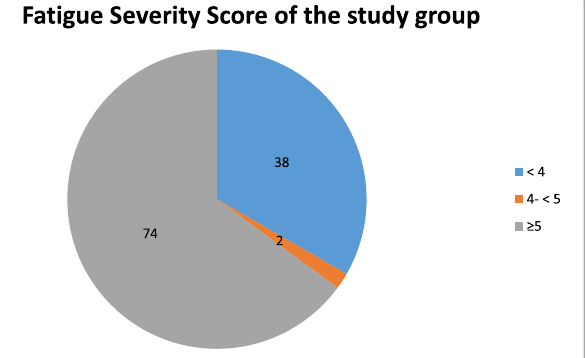
Fig. 1 Fatigue severity score of the study group ( n